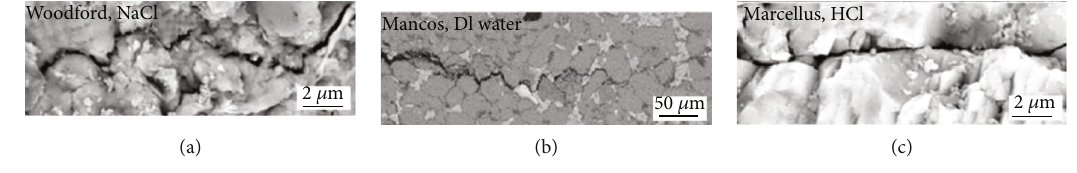
Figure 17: Fracture traces by SEM in Chen et al.